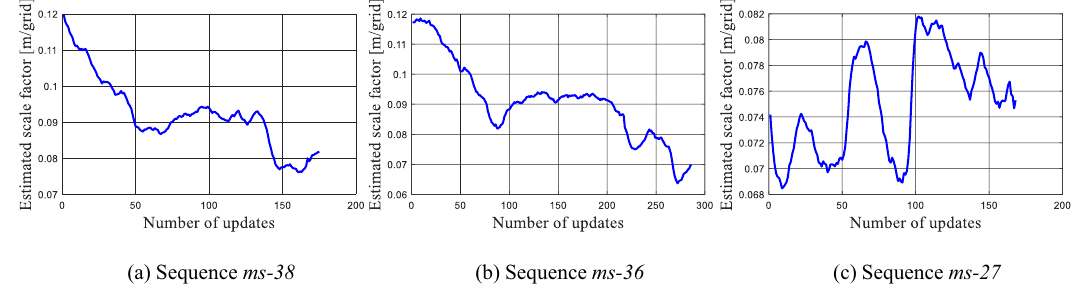
Figure 8. The estimated scale factor in the tests on the benchmark dataset. Table 1. Performance on the MIT Stata dataset.